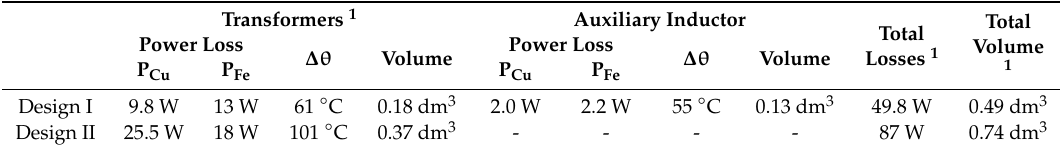
Table 3. Breakdown of losses, volume, and temperature of the two magnetic component designs.